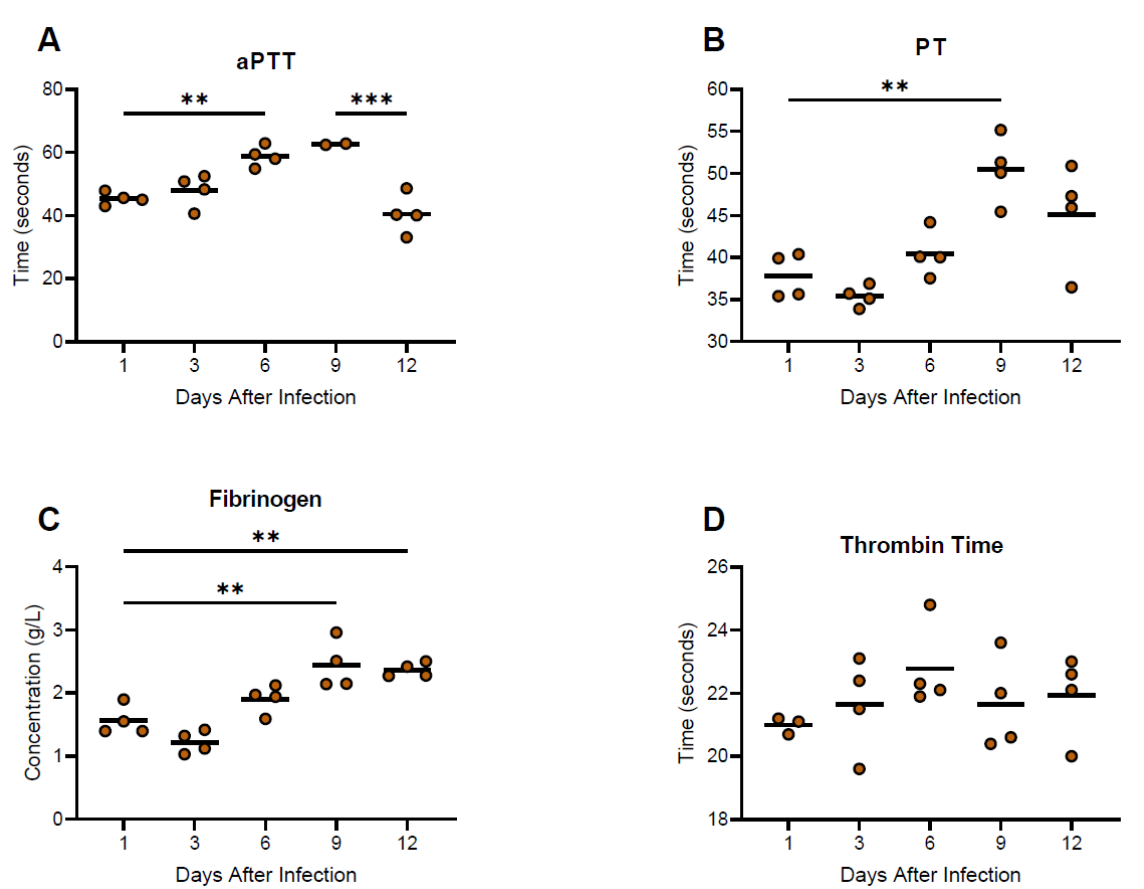
Figure 6. Coagulation profiles from guinea pigs infected with NML-61/GPA. Twenty-four guinea pigs were inoculated with 100LD 50 of NML-61/GPA. Groups of four animals were euthanized at indicated days post-inoculation and analyzed for aPPT ( A ), PT ( B ), Fibrinogen ( C ), and Thrombin time ( D ). Dots represent individual animal values; bar represents group averages. Significant differences where p < 0.01, and <0.001, are indicated by **, and ***, respectively.